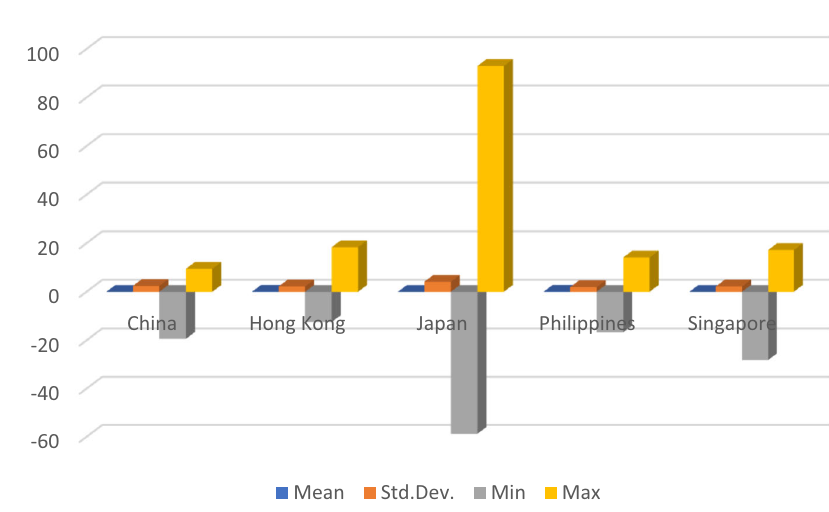
Fig. 3 Mean, standard deviation, maximum, and minimum of the price movement. Note: Mean, standard deviation, maximum, and minimum results are summarized as graphs